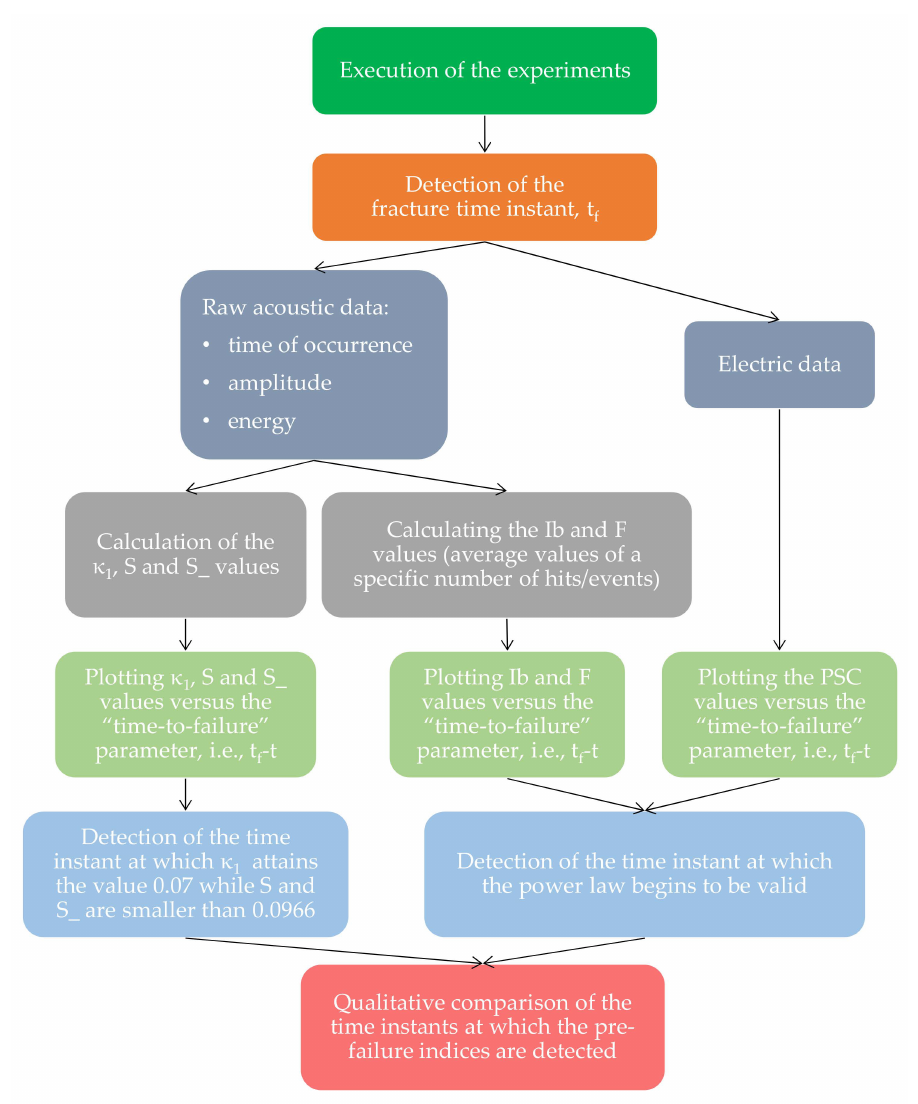
Figure 1. The flow-chart of the